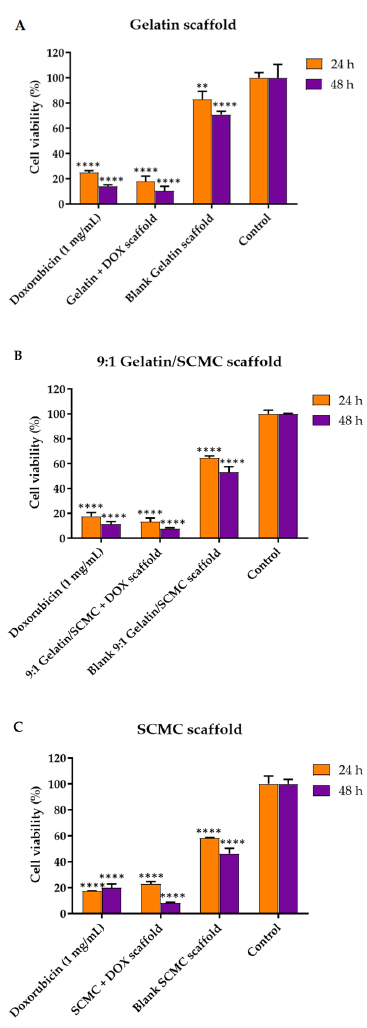
Figure 8. Viability of A549 cells treated with ( A ) gelatin ( B ) 9:1 gelatin/SCMC, and ( C ) SCMC scaffolds containing DOX. Data are expressed as mean ± S.D., ** indicated p < 0.01, and **** indicated p < 0.0001.